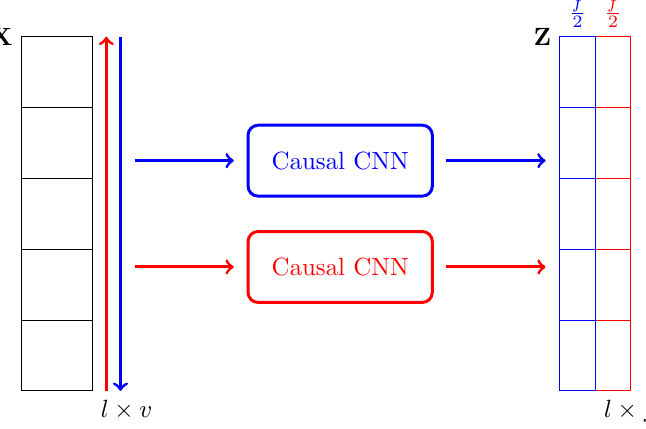
Figure 7. Diagram showing the bidirectionality of the proposed Causal Feature Extractor (CFE) encoder. The intermediate output of the encoder, Z , is the concatenation of two causal convolutions in the opposite directions (blue and red), each of them generating f /2 features. X : Input sequence. l : Length of the input sequence. v : Size of the alphabet in the one-hot encoding. f : Total number of intermediate